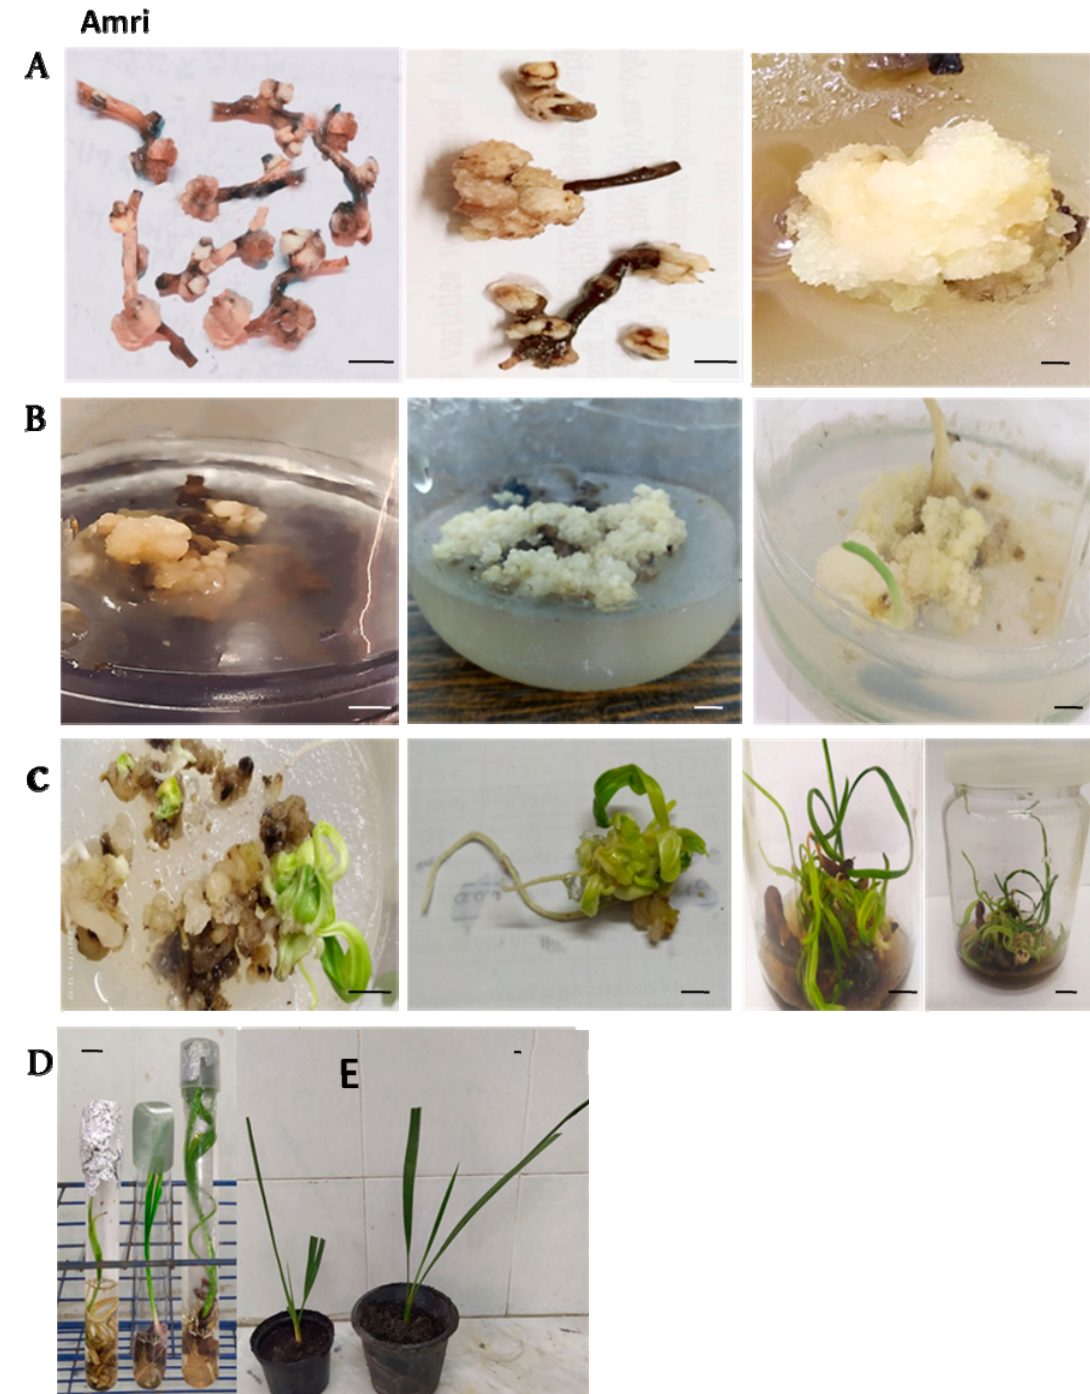
Figure 2. Date palm micropropagation by immature female inflorescences in Amri variety ( A ). Various structures of callus formation and development on starting media after the first subculture, the second subculture and the third subculture, respectively (from left to right). ( B ). Matured embryogenic calli and development of somatic embryogenesis under darkness after 8 weeks, 12 weeks and 16 weeks, respectively (from left to right). ( C ). Germinated somatic embryos and shoot multiplication after 4 weeks, 6 weeks and 12 weeks, respectively (from left to right). ( D ). Shoot rooting. ( E ). Acclimatized plantlets. Scale bar: 1 cm.